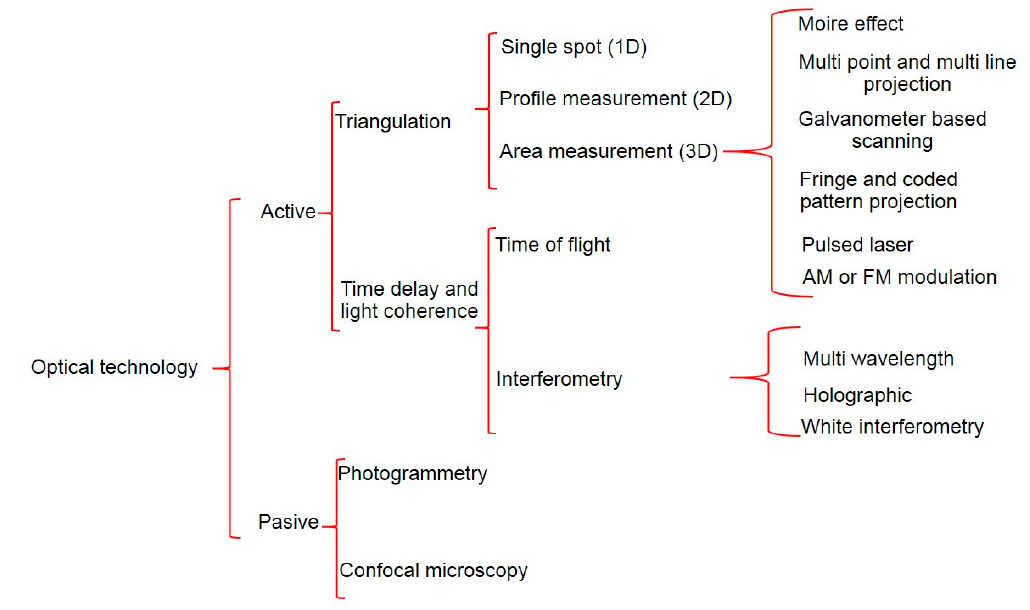
Figure 19. Optical sensing technology map [176].